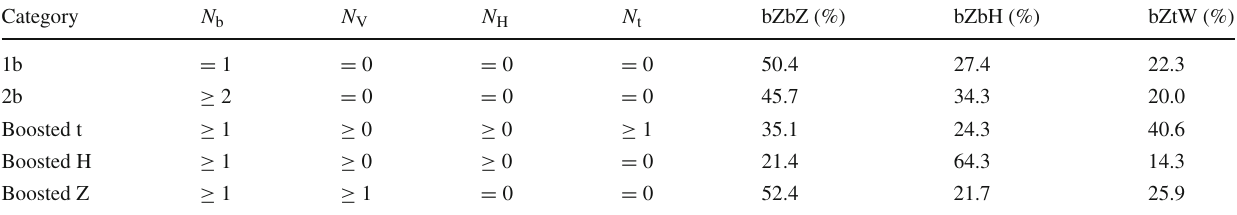
Table 3 The first four columns show different event categories used for the BB search, classified according to the number of AK4 b-tagged jets N b and the number of V → qq, H → bb, and t → qq (cid:7) b candi- dates in the event, N V , N H , and N t , respectively, identified using the jet